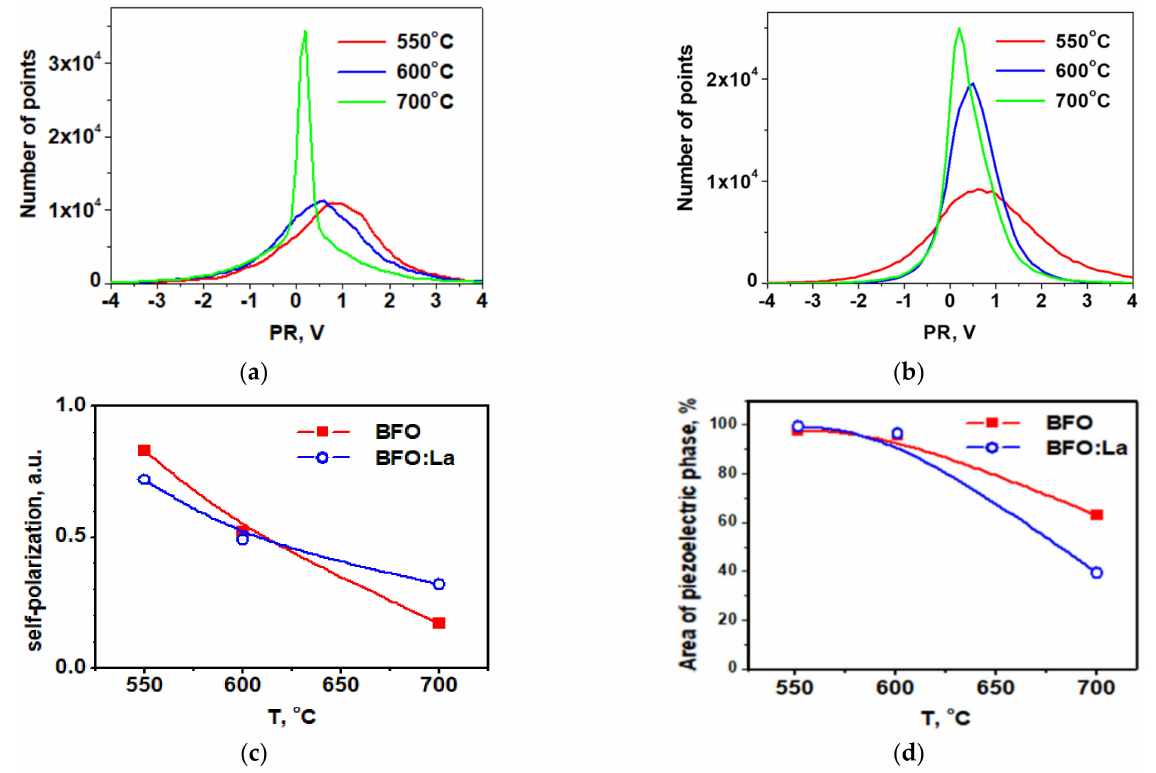
Figure 7. Histograms of the piezoresponse images of BFO ( a ) and BFO:La ( b ) thin films annealed at different temperatures; ( c ) self-polarization in BFO and BFO:La films vs. temperature; ( d ) evolution of areas with piezoresponse after different annealing